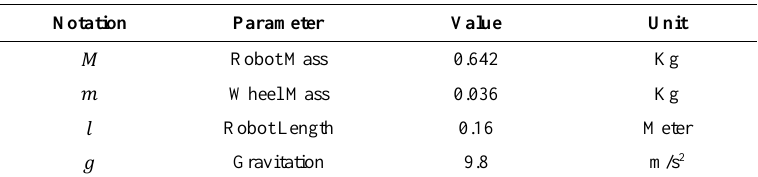
Table 2. Parameters to find transfer function